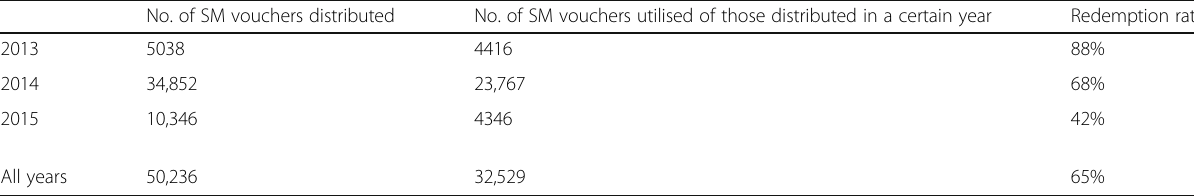
Table 1 Vouchers distributed and vouchers utilised in 2013, 2014 and 2015 in Lahj No. of SM vouchers